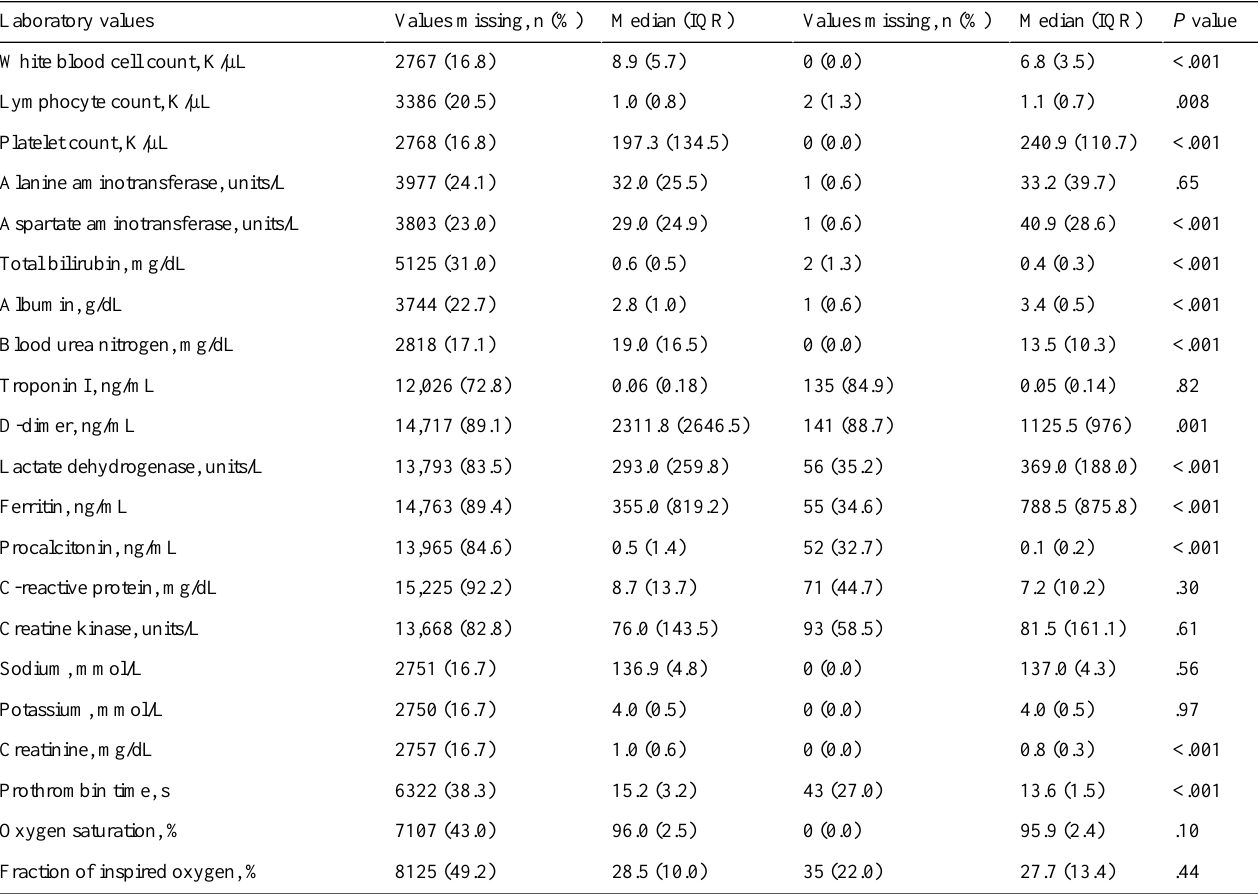
Table 3. Comparison of laboratory values of the COVID-19–like cohort and patients with